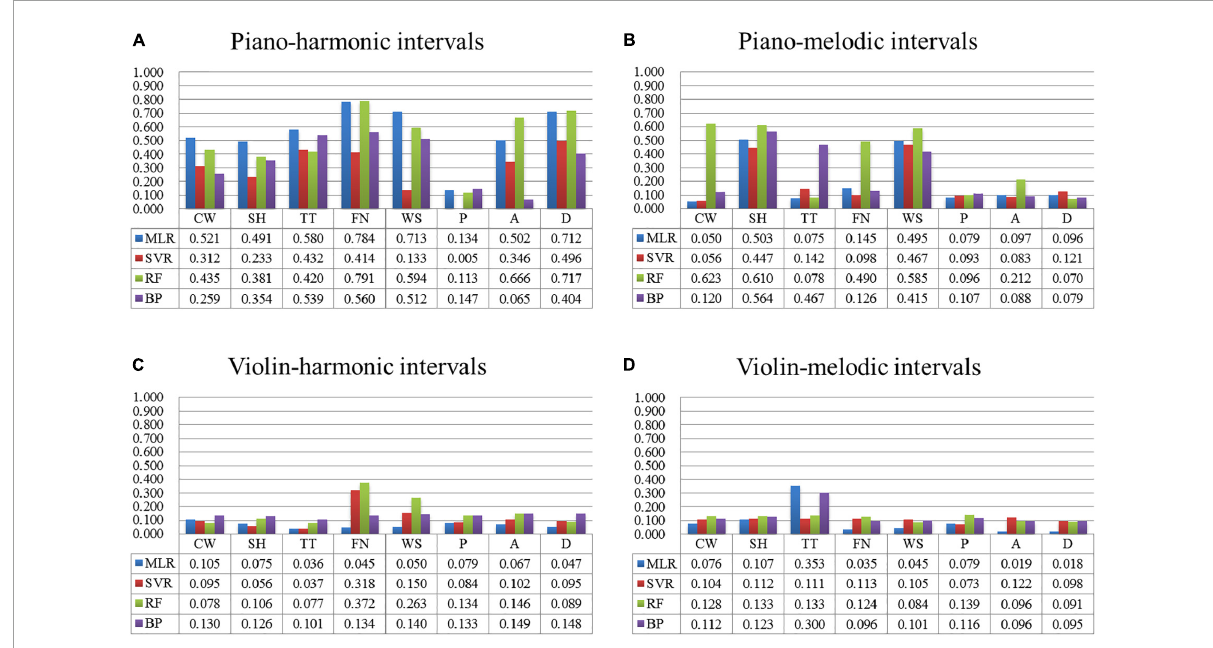
FIGURE7 The comparison on the modeling results of four algorithms of each multi-color perceptual attribute by the interval consonance index. (A) The comparison of four algorithms predicated by piano-harmonic intervals. (B) The comparison of four algorithms predicated by piano-melodic intervals. (C) The comparison of four algorithms predicated by violin-harmonic intervals. (D) The comparison of four algorithms predicated by violin-melodic